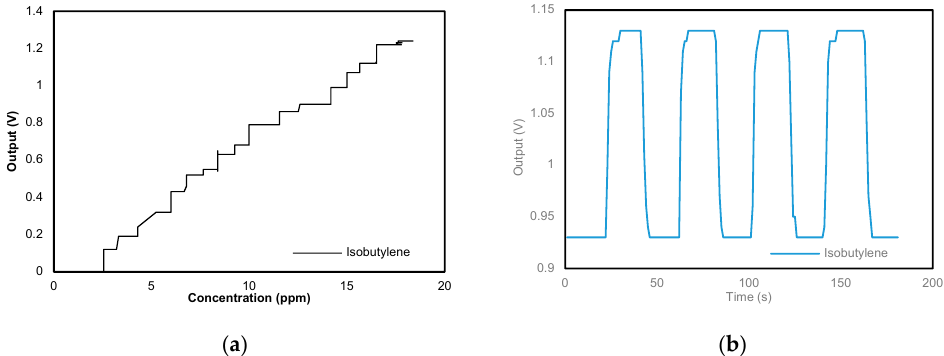
Figure 3. ( a ) Dynamic concentration response for isobutylene; ( b ) Dynamic response for 0 ppm and 15 ppm isobutylene at 10 s intervals.